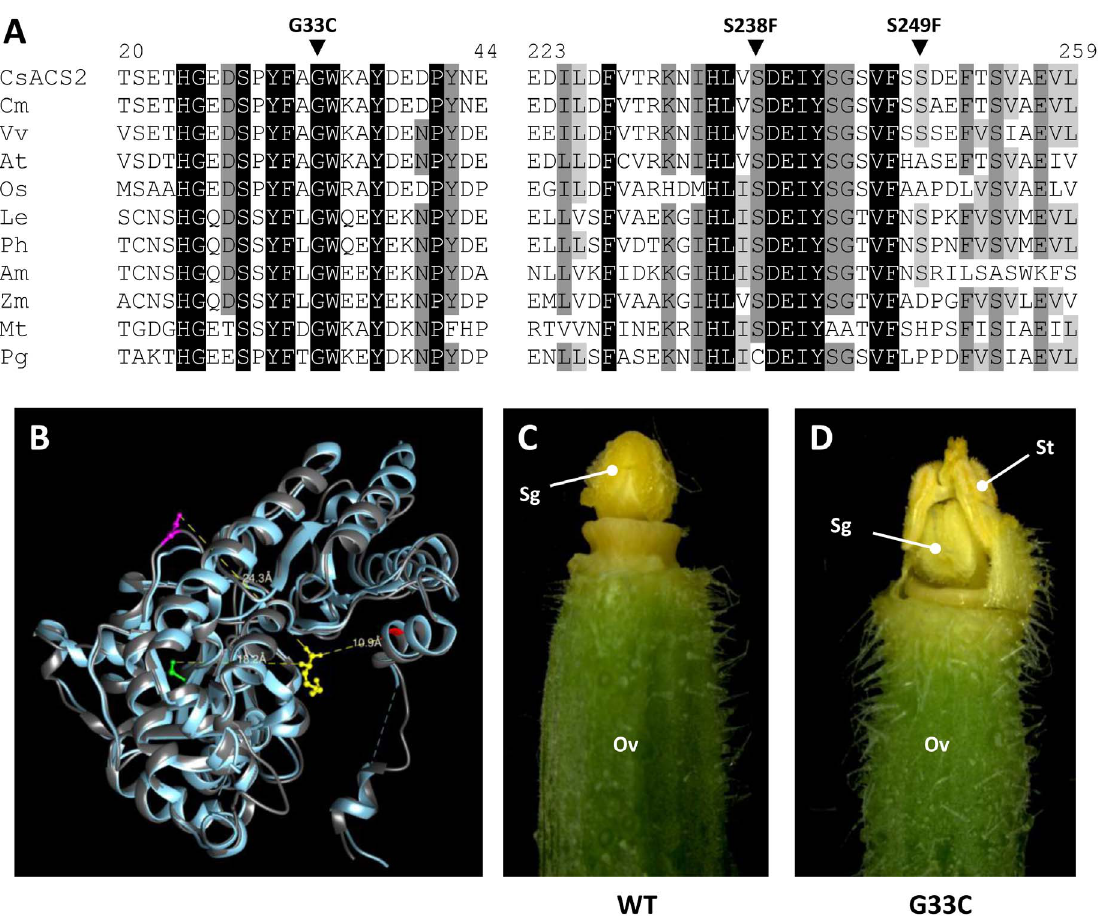
Figure 2. The induced mutation leading to andromonoecy is located in the active site of CsACS2. ( A ) Amino acid alignments of CsACS2 and homologous proteins from Cucumis melo ( Cm ), Vitis vinifera ( Vv ), Arabidopsis thaliana ( At ), Oryza sativa ( Os ), Lycopersicon esculentum ( Le ), Petunia hybrida ( Ph ), Antirrhinum majus ( Am ), Zea mays ( Zm ), Medicago truncatula ( Mt ) and Picea glauca ( Pg ). Numbers above the alignment indicate the amino acid positions along the CsACS2 protein. CsACS2 induced missense mutations, G33C, S238F and S249F are shown above the alignment. ( B ) 3D structure model of CsACS2. Superposition of the tomato ACS structure determined by x-ray crystallography [34], indicated in blue and the 3D model of CsACS2 indicated in grey. CsACS2 model was determined using the Geno3D server (http://geno3d-pbil.ibcp.fr). Ball and stick representations show the competitive inhibitor AVG in yellow, and the amino acids G 33 in red, S 238 in green and S 249 in magenta. ( C–D ) Sexual flower types from monoecious ( C , WT) and the TILLinG andromonoecious mutant ( D , G33C). The male flowers, identical in all the cucumber types are not shown. Ov, ovary; Sg, stigma; St, stamen.